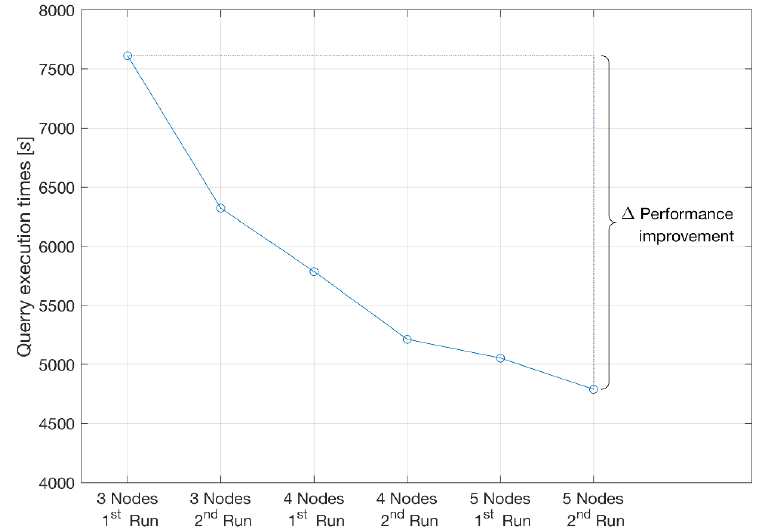
Figure 9. Performance improvement visualisation for TPC-H query execution time. Comparisons of first and second runs on three and five nodes in the Vertica cluster for 1 TB and 3 TB test database sizes.